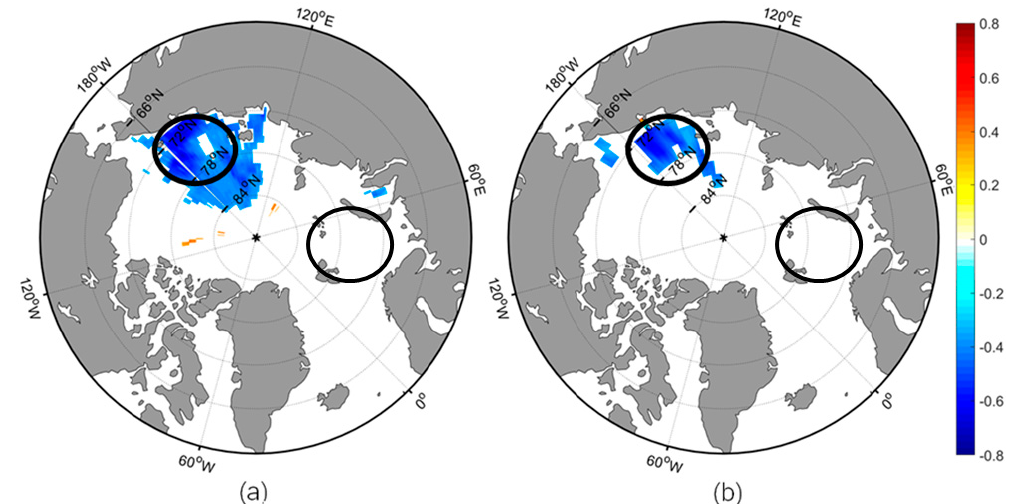
Figure 2. Correlations between autumn arctic sea ice extent and winter Barents–Kara Seas (BKS) precipitation with two data sets: ( a ) Hadley sea ice concentration data set; ( b ) National Centers for Environmental Prediction/Department of Energy (NCEP/DOE) sea ice concentration data set. Note the negative correlation indicated by blue in the circled EES (eastern Siberian Sea) region and white in the circled BKS region. All the data have been de-trended.